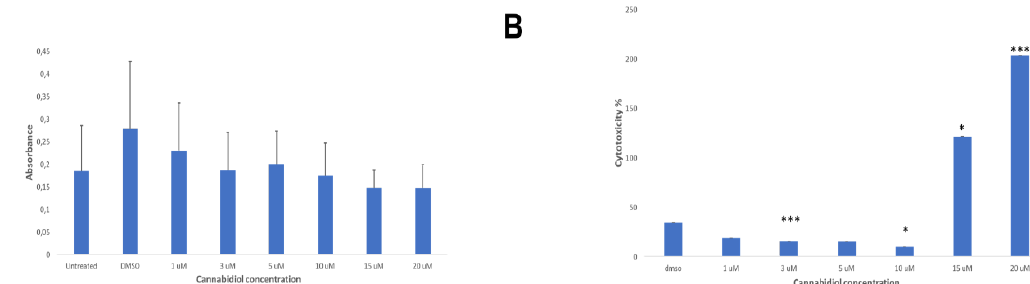
Figure 4. ( A ) The cell viability in KMS-12 PE cells exposed to various concentrations of CBD for 24 h: